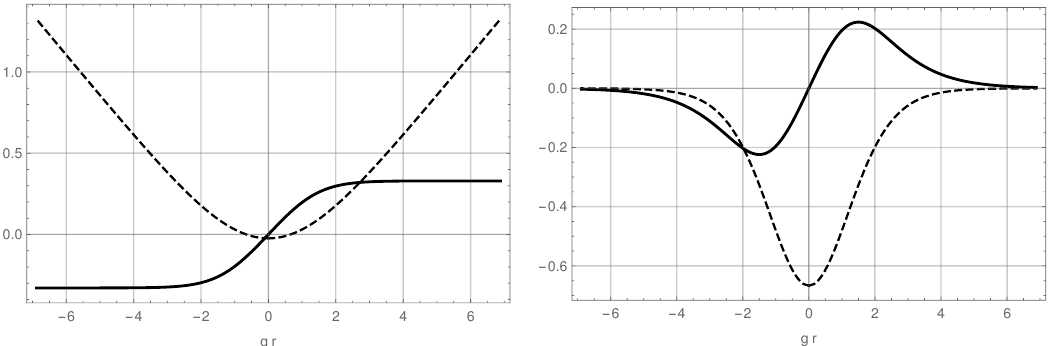
Figure 2. A sample solution with I = 1 = 3 . On the left pane we plot the functions F ( r ) (cid:0) F 0 (solid curve) that controls the solution for ’ and (log X ) = 4 (dashed curve) which through (2.16) represents the warp factor A . On the right pane we plot sinh 4 (cid:11) (solid curve) and sinh 4 (cid:31) (dashed